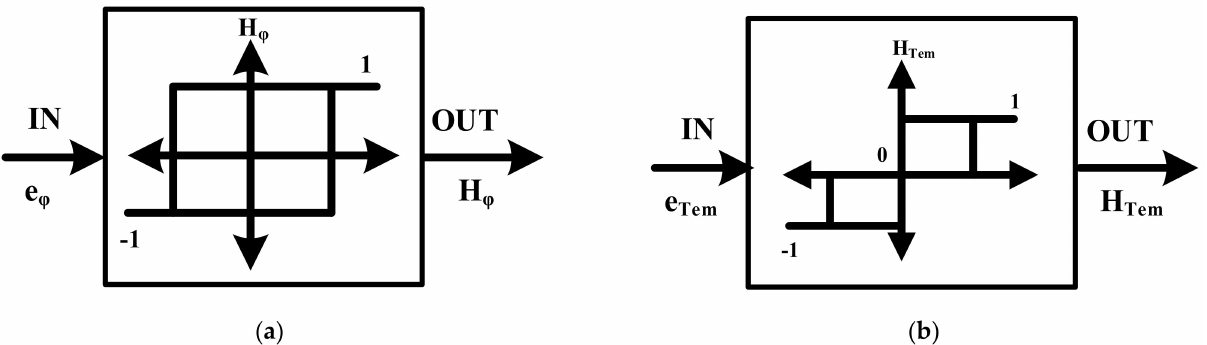
Figure 12. ( a ) A two-level hysteresis comparator for stator flux control and ( b ) a three-level hysteresis comparator for torque